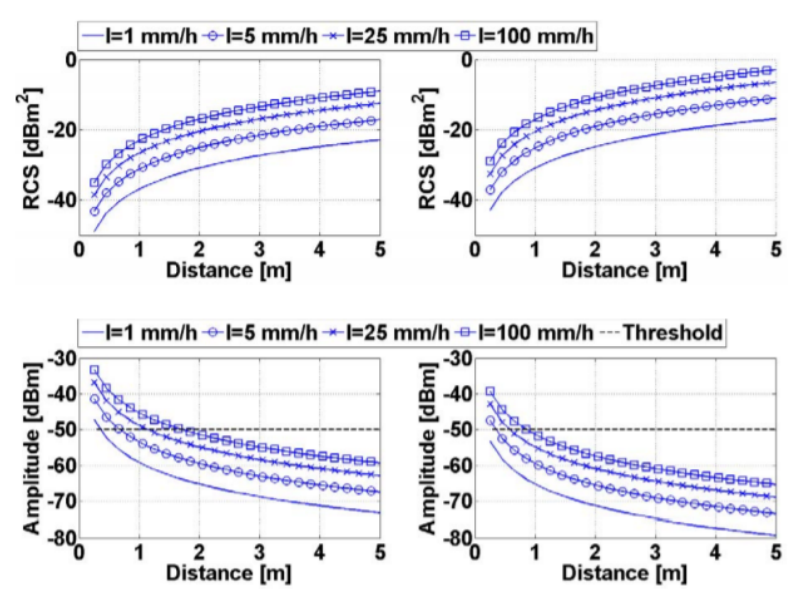
Figure 11. Rain RCS ( top ) and received power ( bottom ) for narrow beam ( left ) and wide beam ( right ) for different rain